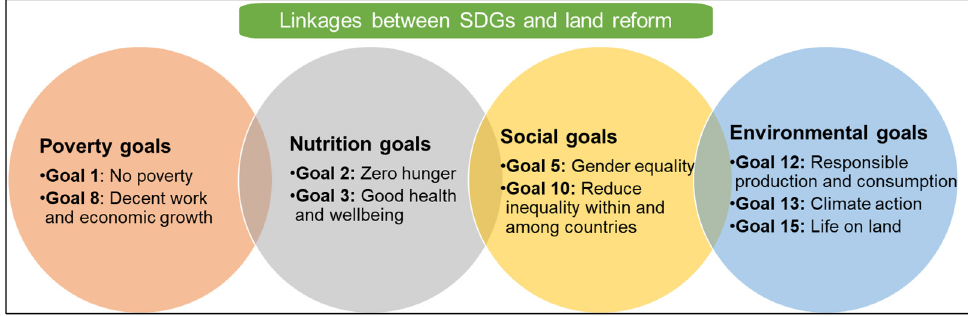
Figure 3. Categorised Sustainable Development Goals directly linked to land reform.